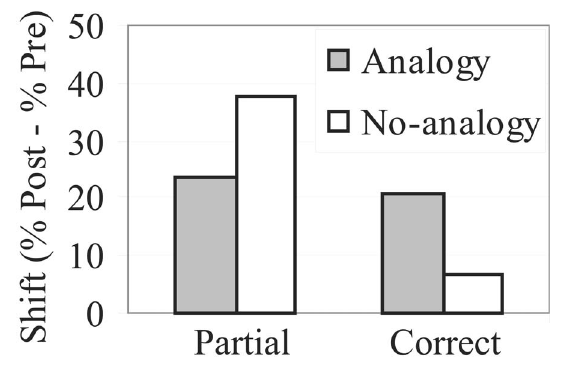
FIG. 9. Results from study 2. Shifts on partially correct answer (cid:1) Partial (cid:2) which includes the 3D feature of EM plane waves. The correct answer includes both 3D and traveling